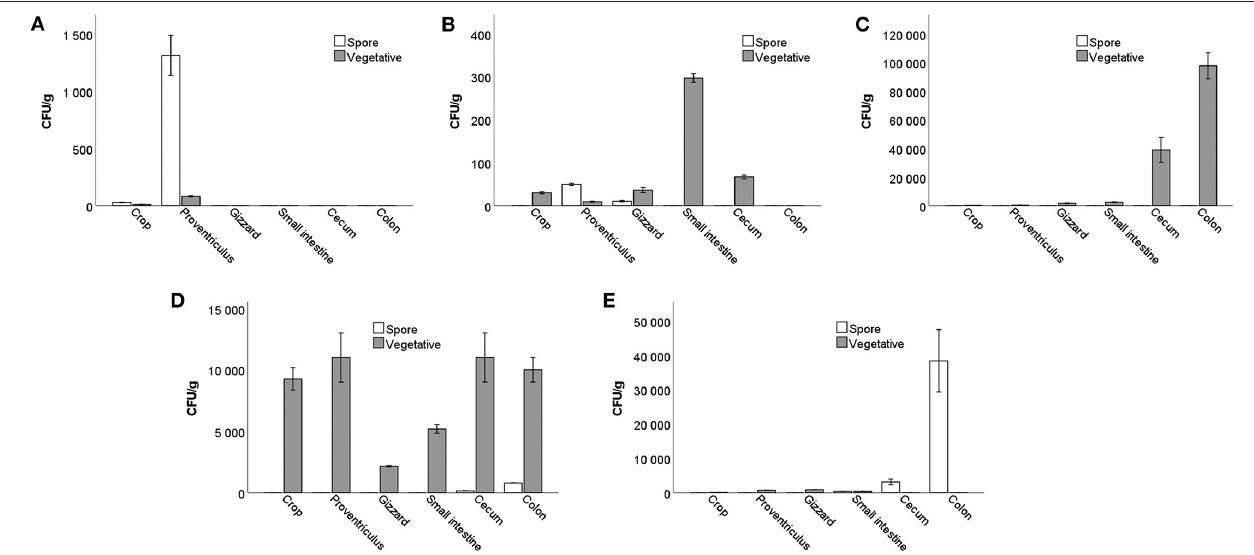
FIGURE 4 | The number of Bacillus vegetative cells and spores in the different parts of the gastrointestinal tract in birds treated with: (A) basal diet without probiotic supplementation; (B) B. subtilis KATMIRA1933; (C) B. subtilis KB16; (D) B. subtilis KB41; (E) B. amyloliquefaciens KB54.